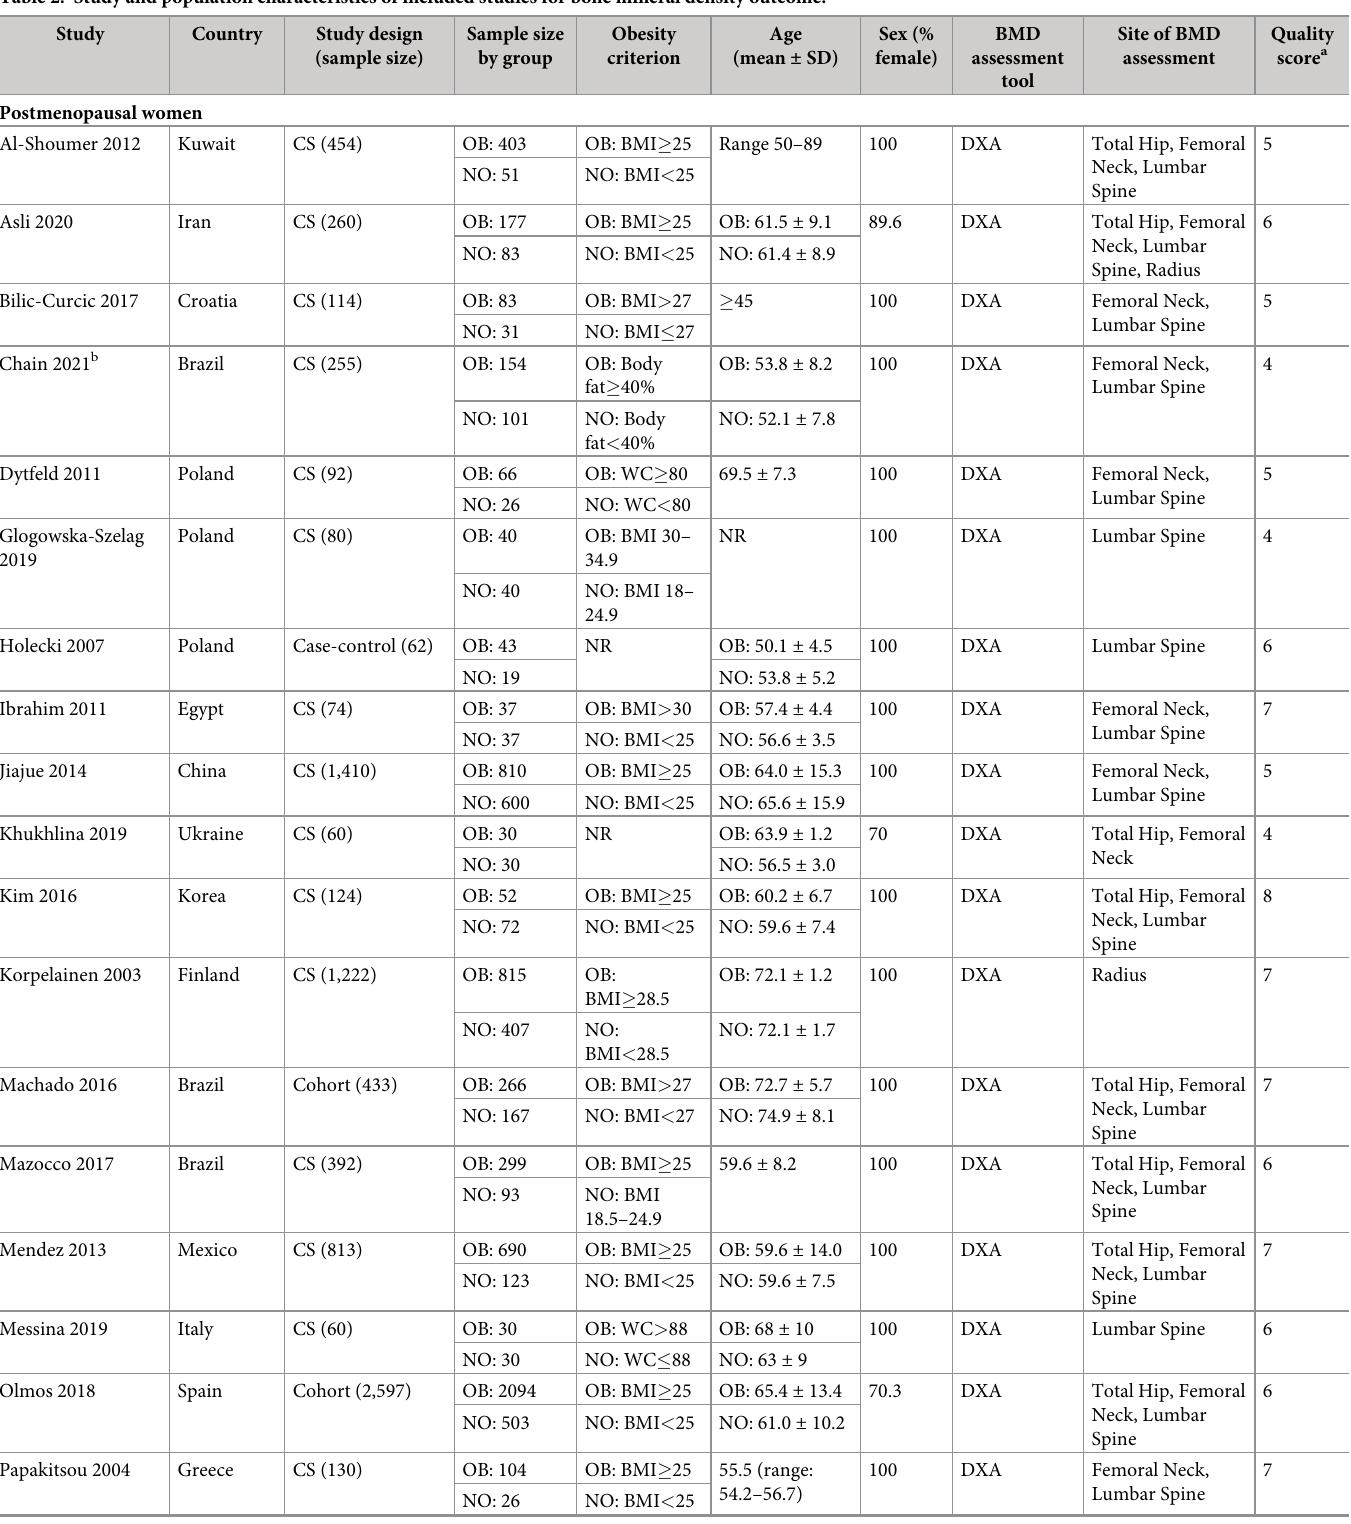
Table 2. Study and population characteristics of included studies for bone mineral density outcome.